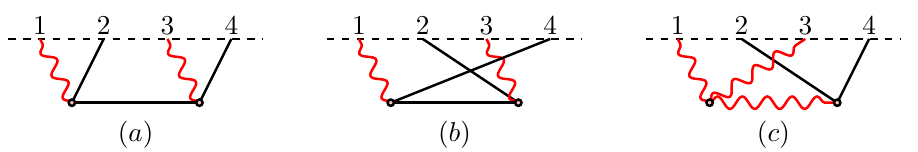
Figure 4 . Witten diagrams for 4-pt correlation function between inflatons and gauge fields. The dashed line is the future boundary of dS spacetime, and the solid line represents the inflaton propagators, while the wavy line is the gauge field propagators. Each pink dot represents the conformally coupled vertex. ( a ) , ( b ) and ( c ) represent for the s , t and u -channel